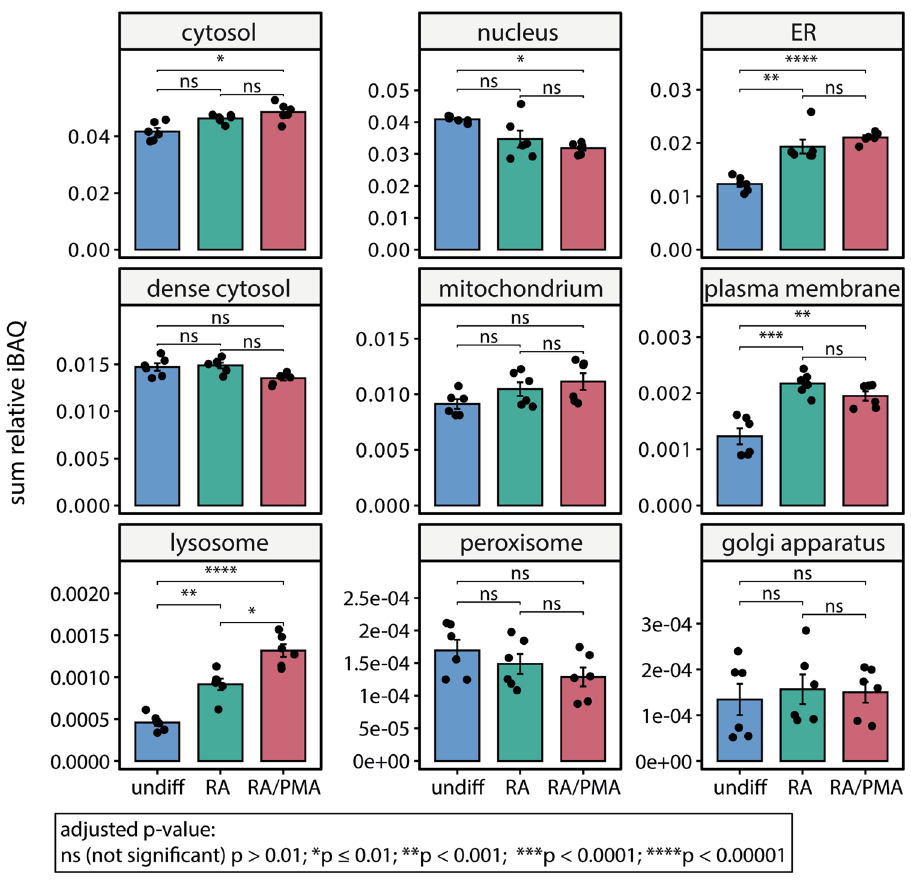
Fig. 2 Relative quanti fi cation of proteins that are linked with a speci fi c subcellular localisation. The relative iBAQ value of all proteins that are linked with a speci fi c subcellular localisation identi fi ed in undifferentiated (undiff, blue), RA-differentiated (RA, green), or RA/PMA-differentiated (RA/PMA, red) cells was summed. For each cell culture condition, the mean value and the standard error are given ( n = 6). The adjusted p -value was calculated using a two-tailed t -test employing the Bonferroni correction method and used to determine signi fi cant differences between the conditions (see legend for details). Figure generated using Supplementary Data